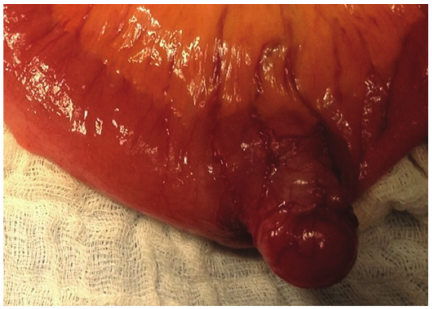
Figure 2: Intraoperative finding: a tumor arising from the ileum with extraluminal growth.